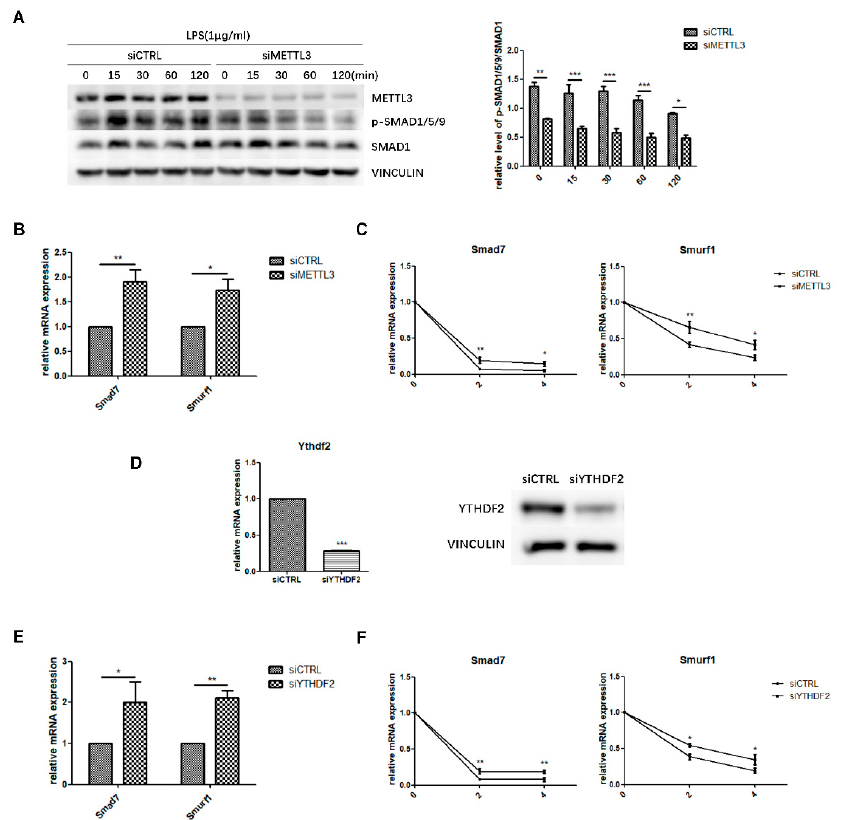
Figure 4. E ff ect of METTL3 or YTHDF2 knockdown on Smad-dependent signaling. ( A ) siMETTL3- or siCTRL-transfected cells were cultured in osteogenic medium for 60 h and then treated with 1 µ g / mL LPS for 0–120 min. Next, Smad1 / 5 / 9 phosphorylation was examined by western blotting. p-Smad1 / 5 / 9 / Smad1 values represent the relative level of signaling activation. VINCULIN was used as an internal reference. ( B , E ) MC3T3-E1 cells were transfected with siRNA (METTL3, YTHDF2, or negative control) and cultured in osteogenic medium for 60 h. Smad7 and Smurf1 mRNA levels were detected by qRT-PCR. Gapdh was used as an internal control. ( C , F ) The mRNA expression of Smad7 and Smurf1 was examined by qRT-PCR in siRNA (METTL3, YTHDF2, or negative control)-transfected cells with osteogenic induction and 0, 2, and 4 h of treatment with 5 µ g / mL actinomycin D. Gapdh was used as an internal control. ( D ) The transfection e ffi ciency of YTHDF2 knockdown was measured by qRT-PCR and western blotting. siCTRL, cells transfected with negative control siRNA; siYTHDF2, cells transfected with YTHDF2 siRNA. The results are shown as the mean ± SD ( n = 3). * p < 0.05, ** p < 0.01, *** p <